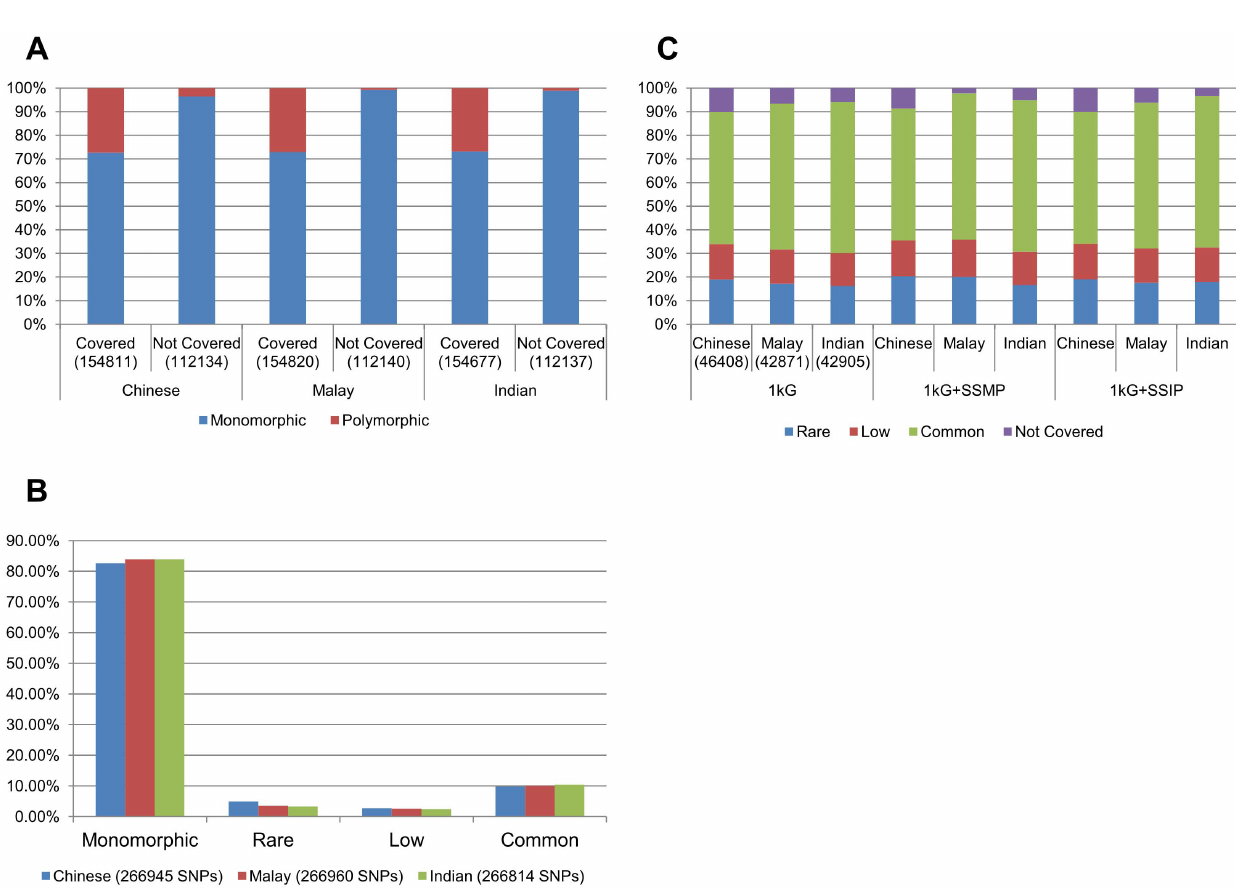
Figure 1. (A) The proportion of monomorphic and polymorphic exonic variants in the Illumina exome chip when assessed in each of the three Singapore populations. The exonic variants on the exome chip are further categorized according to whether they are present in any of the reference panels from the 1000 Genomes Project or the Singapore Sequencing Study for the Malays and Indians (‘‘Covered’’) and can in theory be imputed, or not present in any of the existing reference panels and thus cannot be recovered through imputation (‘‘Not covered’’). (B) Distribution of SNPs on the exome chip according to the minor allele frequencies (MAFs) into monomorphic (MAF =0%), rare (0% , MAF # 1%), low-frequency (1% , MAF # 5%) and common (MAF . 5%) in each of the three populations. (C) MAF categorization of the polymorphic exome chip SNPs in each of the three populations according to whether these SNPs are present (non-purple bars) or not (purple bars) in the respective reference panels. Numbers in brackets indicate the number of SNPs in the respective